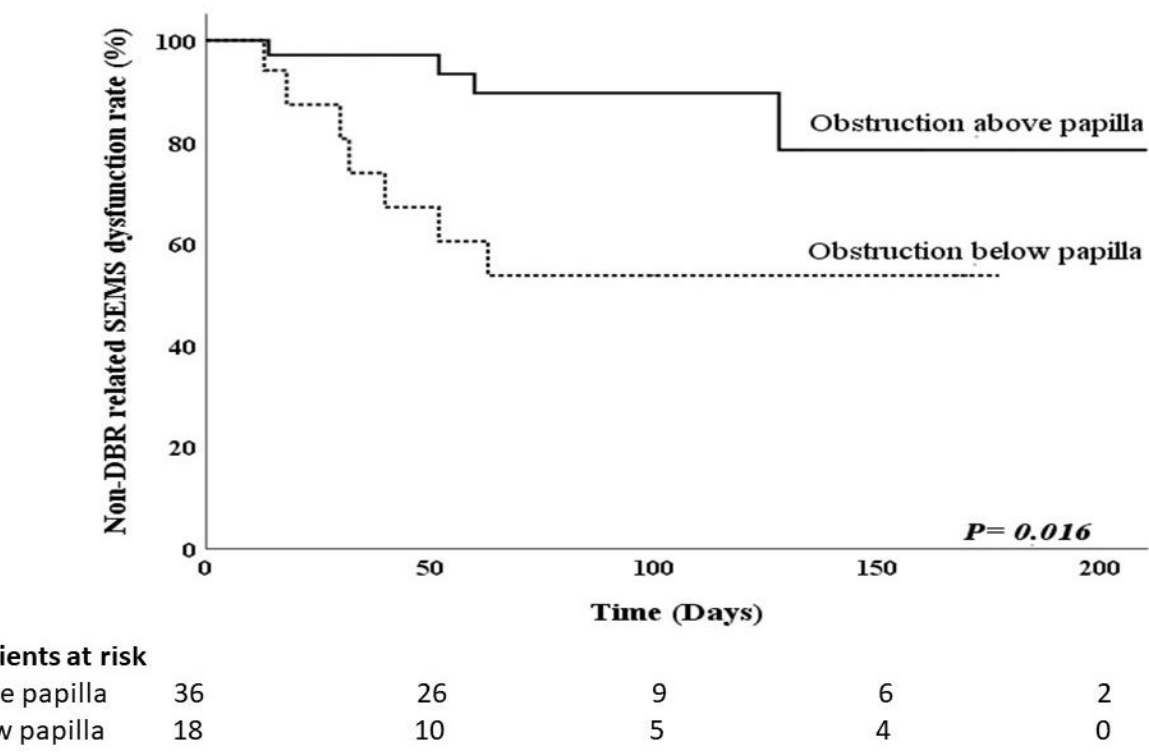
Figure 1. Kaplan–Meier curve showing time to duodenobiliary reflux (DBR)-related covered biliary self-expandable metal stents (SEMS) dysfunction according to the obstruction site of the duodenum. Table 3. Risk factors for duodenobiliary reflux-related stent dysfunction after treatment of duodenal